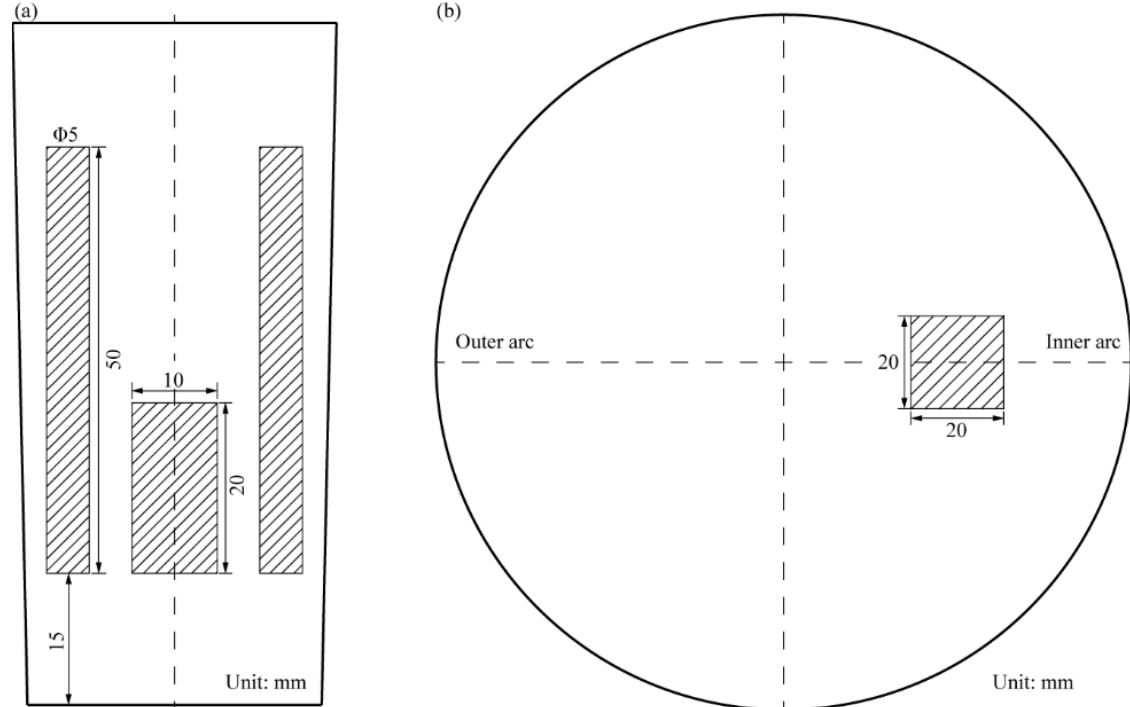
Figure 1. Cutting position and size of sample: ( a ) bucket sample, ( b ) round billet.